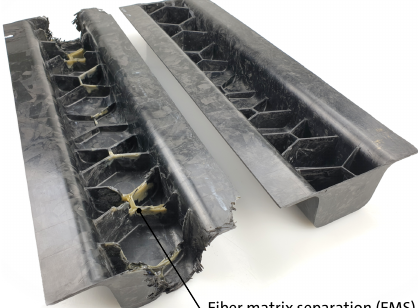
Figure 12. Ribbed structure compression molded with a simple quadratic HexMC charge pattern and unsuited molding parameters showing extensive fiber matrix separation (FMS) (left) compared to a part molded with a pre-heated and optimized charge pattern developed by means of filling simulation studies using 3D TIMON CompositePRESS (right) (plate areas are removed from the ribbed hat profiles).